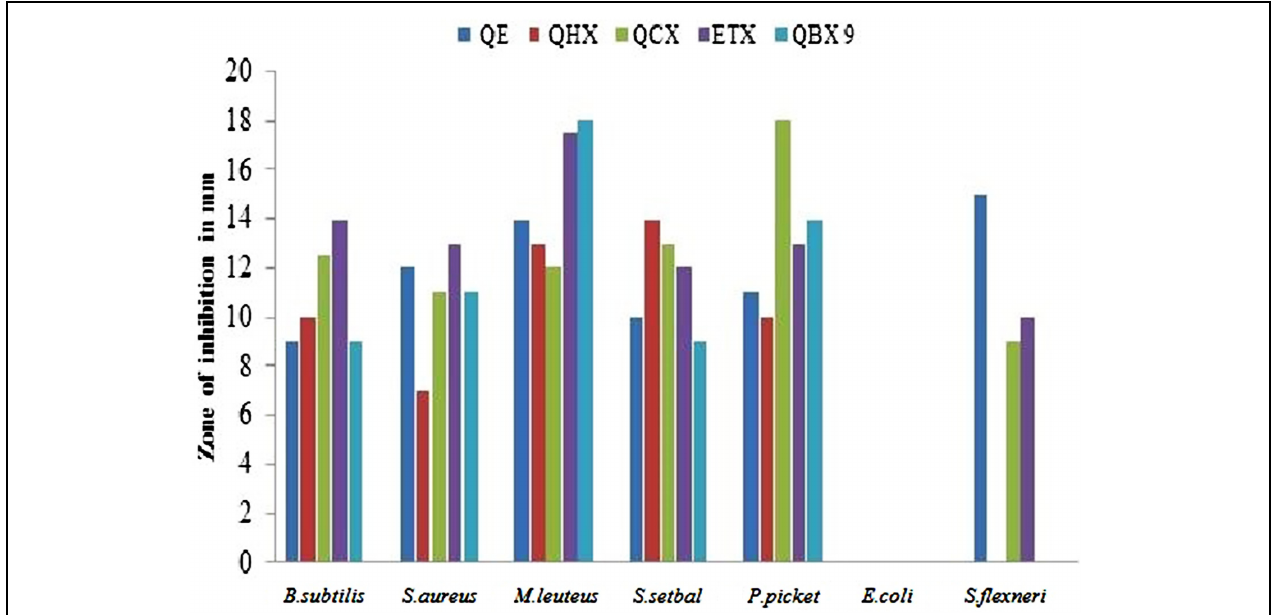
FIGURE 3 | Antibacterial activity of fractions against bacterial strains. B. subtilis , Bacillus subtilis ; S. aureus , Staphylococcus aureus ; M. leuteus , Micrococcus leuteus ; S. setuba l , Salmonella setubal ; P. pickettii , Pseudomonas pickettii ; E. coli , Escherichia coli ; S. flexneri , Sigella flexneri .